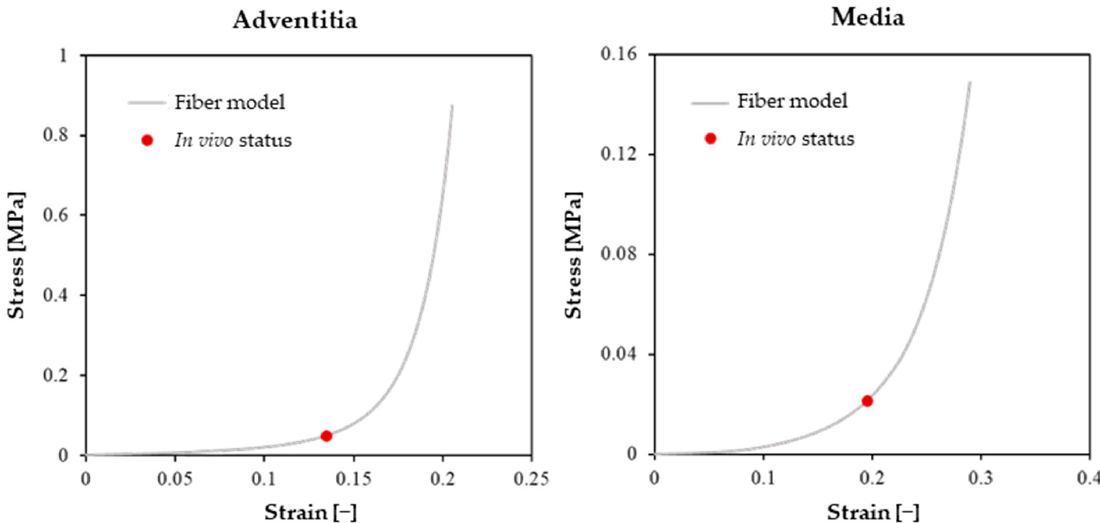
Figure 3. Circumferential stress-strain curves for adventitia ( left ) and media ( right ) described with the fiber-reinforced models obtained through the pre-stretching and pressurization of the two-layered cylinder. The red dots indicate the in vivo status configuration. Table 1. Material models of adventitia and media: summary of the parameters of the 6th order re- duced polynomial strain energy density function (Equation (3)) calibrated to fit the circumferential stress-strain curves of the fiber-reinforced model considering the in vivo status configuration as zero-condition.